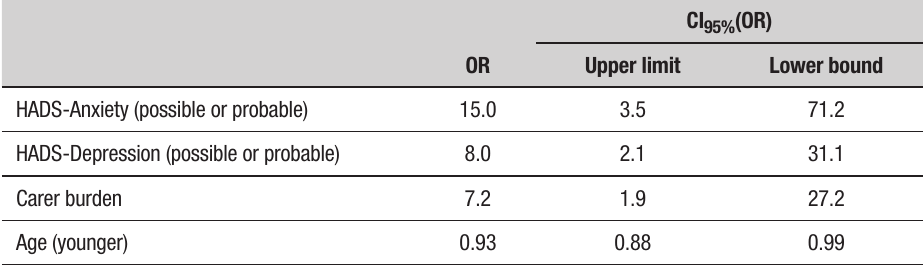
Table 2. Estimates and 95% Confidence Intervals (CI) of odds ratios (OR), obtained by the logistic regression model.